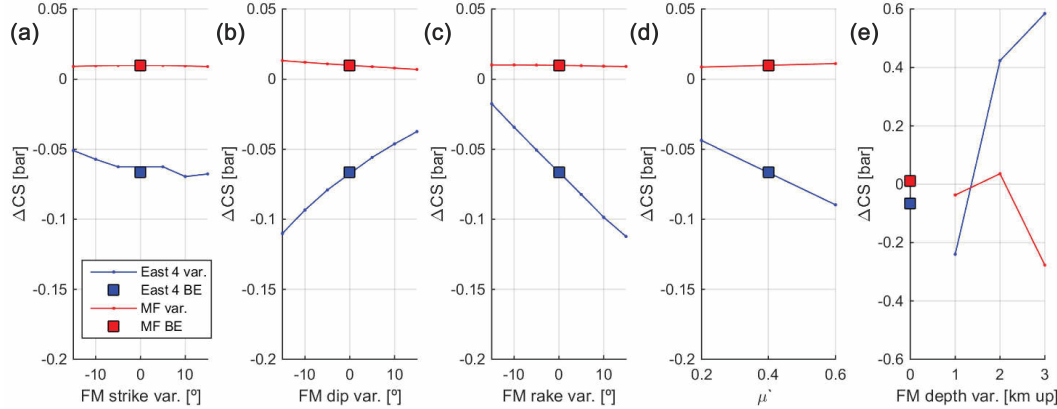
Figure 7. Sensitivity analysis result on the East 4 and Main Fault (MF). The figure shows average values (as obtained from all modeled patches). Squares refer to the best estimation of parameters, and lines depict the (cid:49) CS variation resulting from each parameter change as reported in Table C3. Except for panel (d) , which directly reports the µ ’ value in the x axis, only the introduced variation (e.g., − 15 to + 15 ◦ in the strike direction) is reported. Note that vertical scale changes for the depth variation (e)